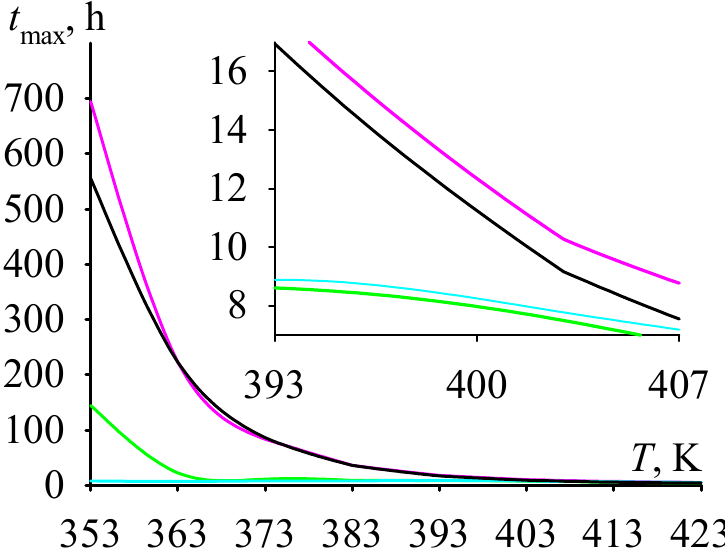
Figure 4. Time to reach the maximum concentration of cumene hydroperoxide depending on the temperature of cumene oxidation. Without catalyst Ca Sr Ba . G = 0.6 L/min, P = 1 atm, [RH] 0 = 6.19 mol/L, [ROOH] 0 = 0.15 mol/L, [ROH] 0 = 0.08 mol/L, [HCOOH] 0 = 0.018 mol/L, [C 6 H 5 C(O)CH 3 ] 0 = 0.024 mol/L, and [Cat] 0 = 1 mmol/L.